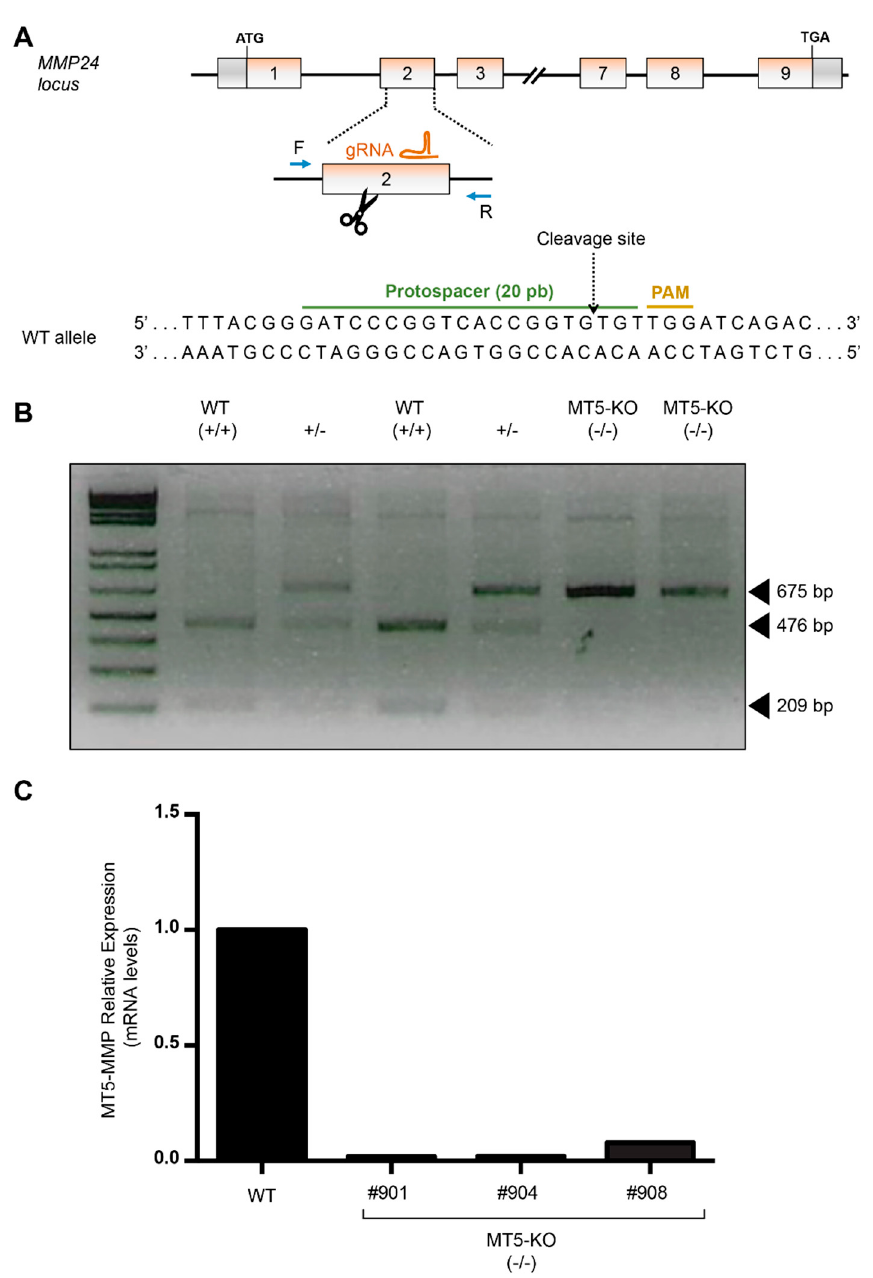
Figure 1. MT5-MMP ( MMP24 )-KO hiPSC generation by CRISPR/Cas9 genome editing. ( A ) Schematic representation of the wild-type (WT) locus and the genome editing strategy used to generate the knockout (KO) isogenic clones from a non-demented donor hiPSC line. ( B ) Representative PCR-based screening for the editing of MMP24 : WT (+/+), heterozygous (+/ − ) and homozygous MT5-KO ( − / − ) clones. The F and R primers for MMP24 were designed flanking the Cas9-cutting site. The PCR product was digested and run on an electrophoresis gel, to analyze the size of the amplicon for each individual clone (expected profiles: two bands at 476 bp and 209 bp (WT +/+); one band at 675 bp (restriction enzyme site obliterated, MT5-KO -/-) and three bands at 675bp, 476bp and 209bp (heterozygous clones, +/ − ). ( C ) After Sanger sequencing validation of MT5-KO clones (not shown), qPCR analysis revealed that MMP24 mRNA was barely detectable in the newly generated MT5-KO clones.